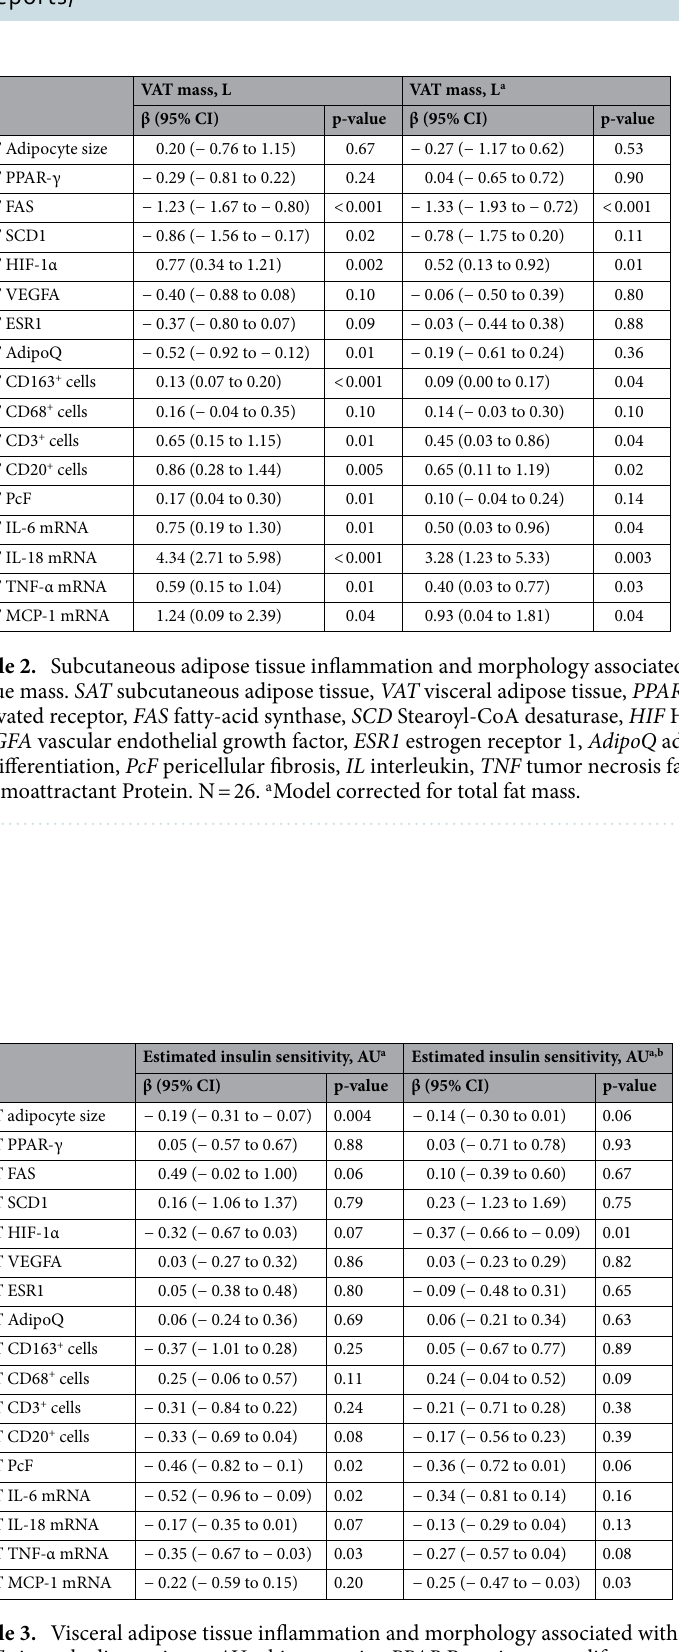
Table 3. Visceral adipose tissue inflammation and morphology associated with estimated insulin sensitivity. VAT visceral adipose tissue, AU arbitrary units, PPAR Peroxisome proliferator activated receptor, FAS fatty-acid synthase, SCD Stearoyl-CoA desaturase, HIF Hypoxia-inducible factor, VEGFA vascular endothelial growth factor, ESR1 estrogen receptor 1, AdipoQ adiponectin, CD cluster of differentiation, PcF pericellular fibrosis, IL interleukin, TNF tumor necrosis factor, MCP Monocyte Chemoattractant Protein. N = 25. a Estimated insulin sensitivity calculated through Composite Matsuda Index. b Model corrected for VAT mass.